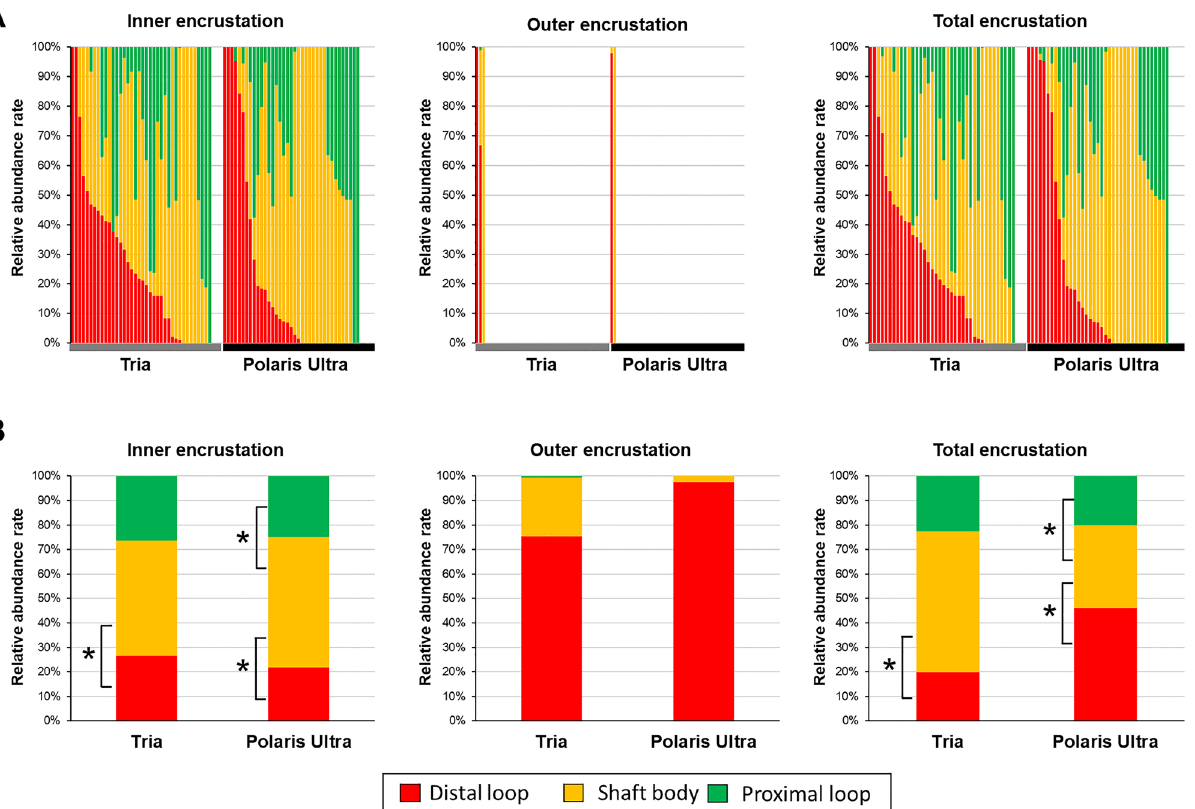
Figure 2. The relative abundance of encrustation at each stent portion (proximal loop/shaft body/distal loop) in each patient ( A ), and the average of each group ( B ). Height color bars demonstrate the percentage of encrustation volume at each portion, and the case with no bar displayed had no stent encrustation. The Friedman test with the Bonferroni correction was used for statistical analysis. * P <